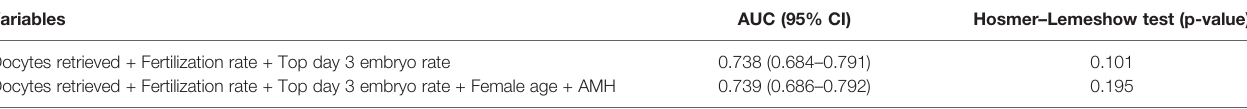
TABLE 5 | Comparison of performance among prediction models in endometriosis group.